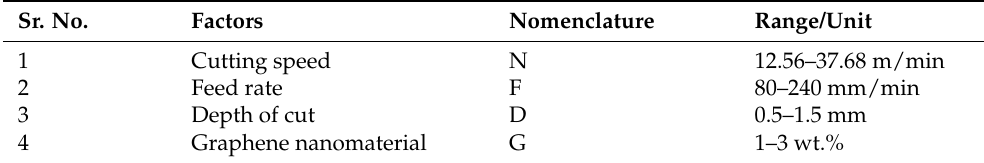
Table 2. Process parameters and their working range. Sr. No.